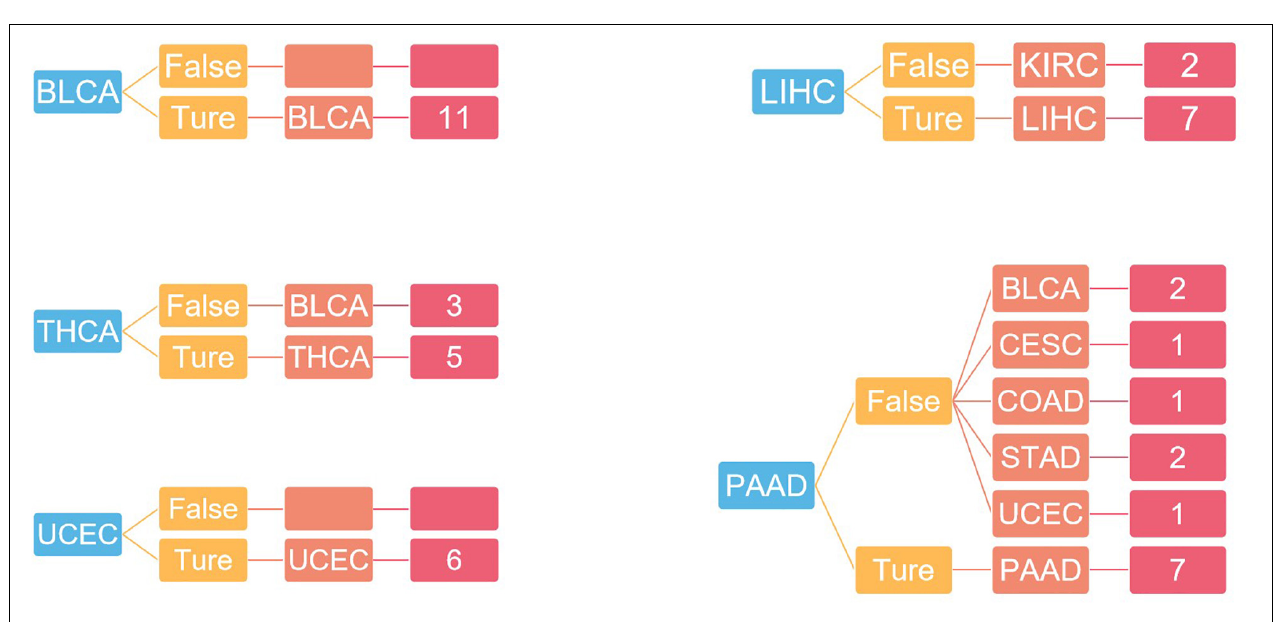
FIGURE 6 | The result of independent verification. Blue represents the primary tumor, orange represents the accuracy of the prediction, light red represents the predicted tumor type, and dark red represents the number of predicted tumor types.